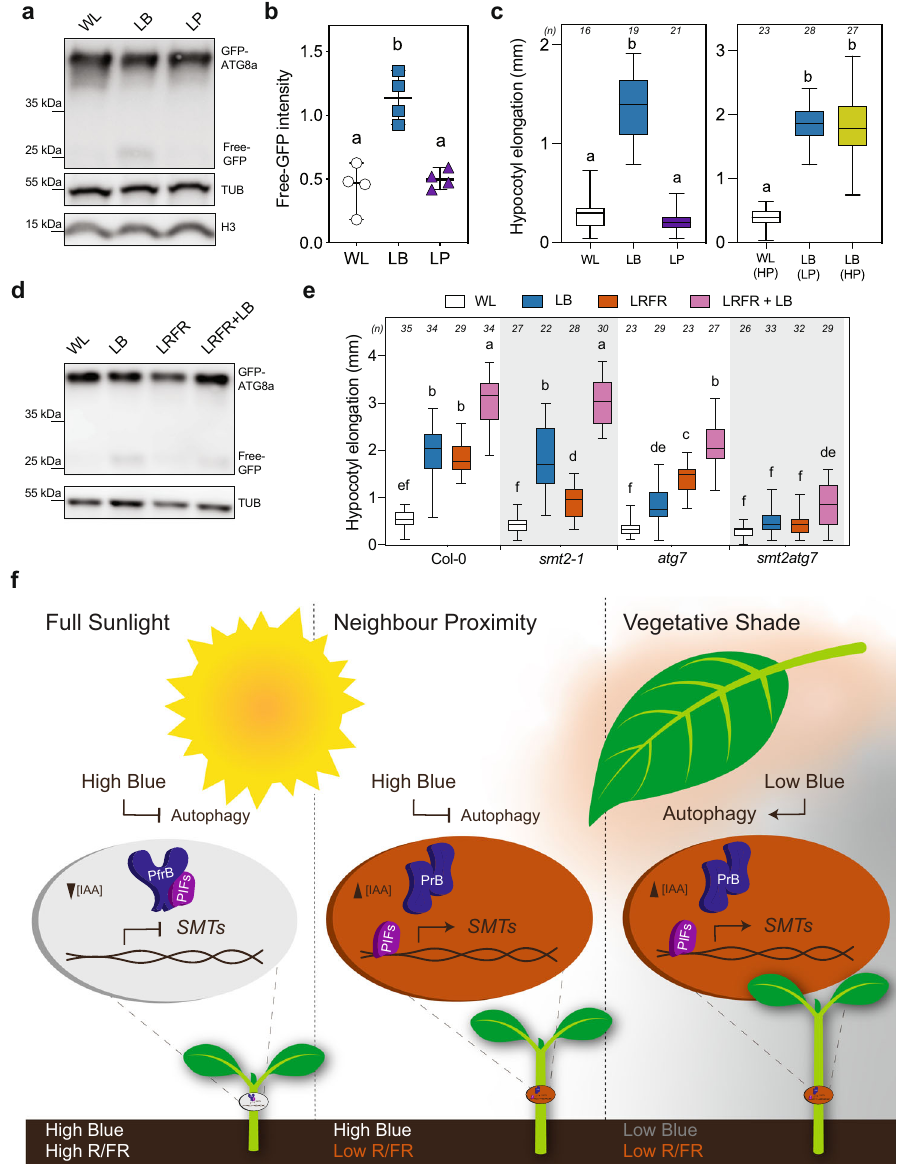
Fig. 8 | Hypocotyl elongation phenotypes correlate well with induction of autophagy inresponse to changing light environments. a Westernblot analysis of GFP-ATG8a and free GFP in WT seedlings treated for 8h with LB or LP without ConA. b Quanti fi cation of free-GFP bands in ( a ). Each data point indicates a bio- logically independent sample (average of two technical replicates for each data point),horizontalbarrepresentsthemedian,andwhiskersextendtoshowthedata range. c Hypocotyl elongation of WT seedlings treated with LB, LP, or LB with increased PAR (High PAR, HP) compared to WL. d GFP-ATG8a and free-GFP levels are detected in WT seedlings treated with 8h of LB, LRFR, or LRFR+LB without ConA. e Hypocotyl elongation of seedlings with the indicated genotypes